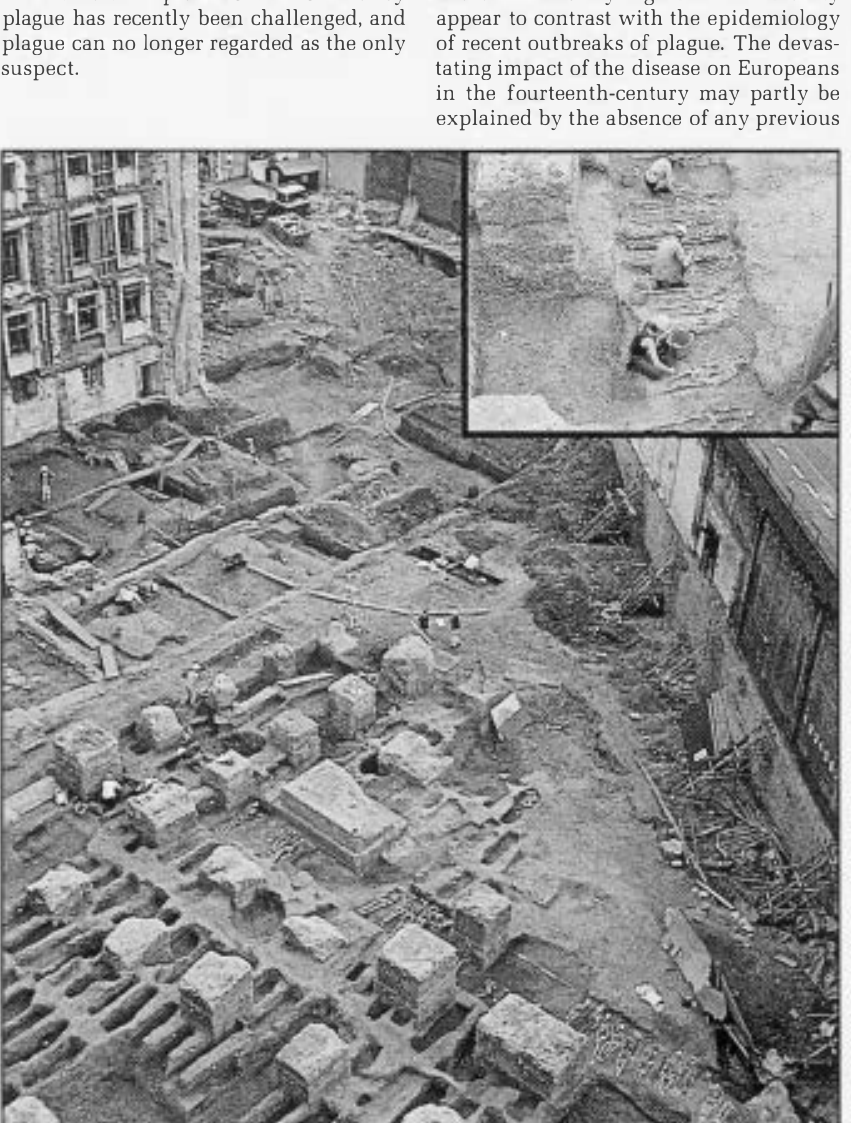
Figure 1 Mass-burial trench and graves from the Black Death cemetery of East Smith­ field in London, excavated by archaeologists from the Museum of London; the inset shows part of the mass-burial trench under